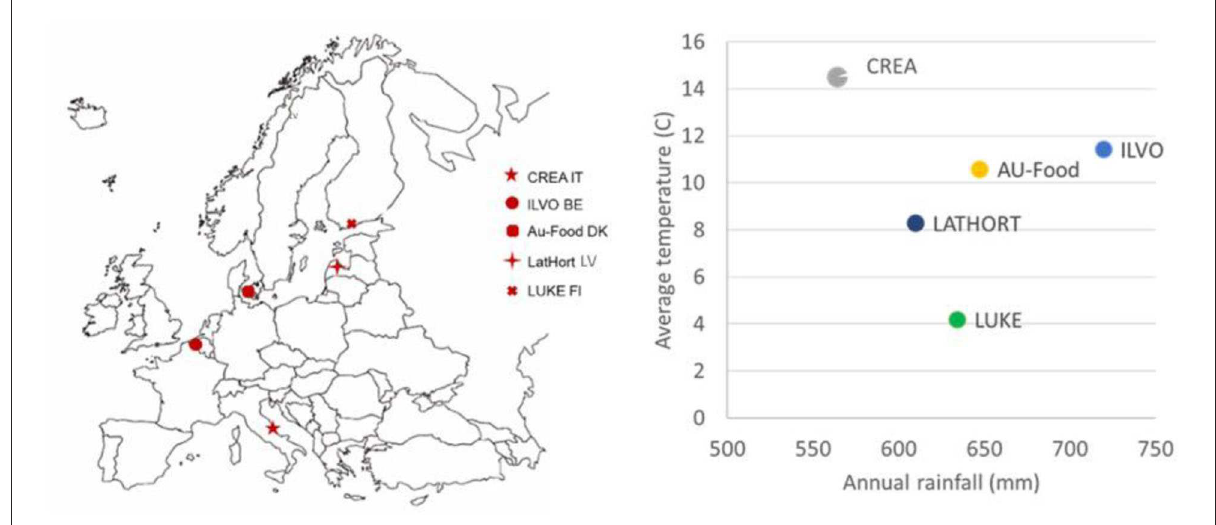
FIGURE1 SureVeg experimental sites and related annual rainfalls (mm) and average annual temperatures ( ◦ C,